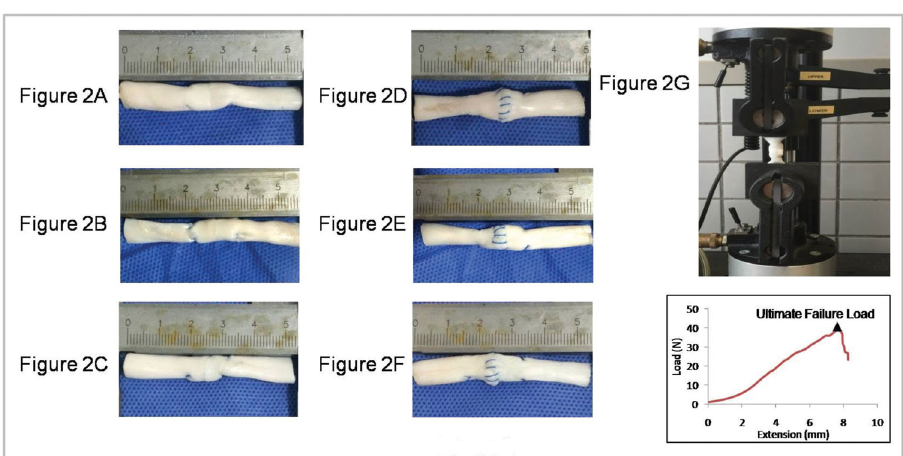
Figure 2 - Repaired porcine tendon with various suture techniques. (A) Modified Kessler suture without epitendinous suture (MK); (B) double knot Kessler-loop lock flexor tendon suture without epitendinous suture (DK); (C) single knot Kessler-loop lock flexor tendon suture without epitendinous suture (SK); (D) Modified Kessler suture with epitendinous suture (MK + P); (E) double knot Kessler-loop lock flexor tendon suture with epitendinous suture (DK + P); (F) single knot Kessler-loop lock flexor tendon suture with epitendinous suture (SK + P). (G) The repaired porcine tendon in mechanical testing and the Load-deformation curve in test.